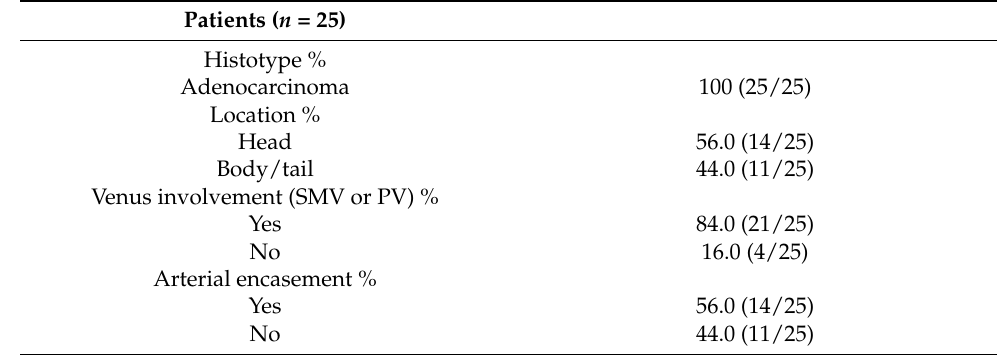
Table 1. Characteristics of locally advanced pancreatic cancer patients treated with